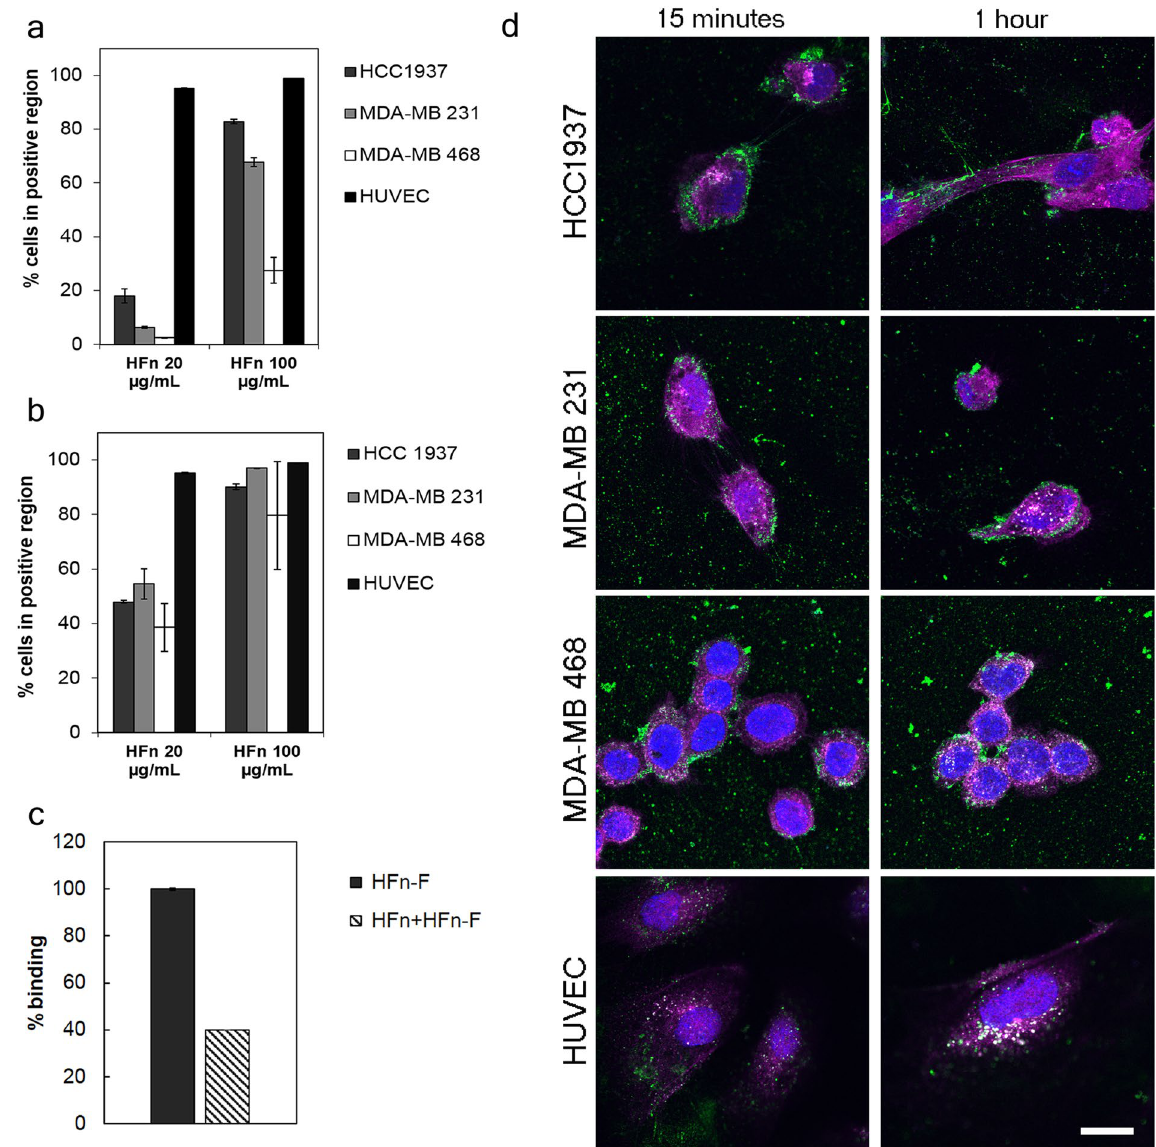
Figure 1. HFn recognition of Triple-Negative Breast Cancer cells. ( a ) MDA-MB 231, MDA-MB 468, HCC1937 (for TNBC) and HUVEC cells were incubated 2 h at 4 °C in PBS buffer and 0.3% BSA with different amounts of FITC-labelled HFn nanoparticles (20 and 100 µ g/mL). Then, cells were processed for flow cytometry, using untreated cells to set the positive region and the singlet gate. Reported values are the mean ± s.e. (n = 3). ( b ) MDA-MB 231, MDA-MB 468, HCC1937 (for TNBC) and HUVEC cells seeded in a multiwell plate were incubated 1 h at 37 °C in complete cell culture medium with different amounts of FITC-labeled HFn nanoparticles (20 and 100 µ g/mL). Then, cells were detached, washed and processed for flow cytometry, using untreated cells to set the positive region and the singlet gate. Reported values are the mean ± s.e. (n = 3). ( c ) Competition assay. HCC1937 cells were incubated 1 h at 37 °C with 100 µ g/mL of FITC-labelled HFn with or without an excess of unlabeled HFn ( i.e ., 5 mg) as competitor. Cells were then detached and treated for flow cytometry. Untreated cells have been used to set the singlet gate and the positive region. Reported values are the mean ± s.e. (n = 3). ( d ) Colocalization of HFn and TfR1. Confocal images of MDA-MB 231, MDA-MB 468, HCC1937 (for TNBC) and HUVEC cells incubated 15 min or 1 h at 37 °C in complete cell culture medium with FITC-labeled HFn nanoparticles (green; 100 µ g/mL). Nuclei were stained with DAPI (blue). TfR1 was recognized with anti-TfR1 antibody (Abcam) and labeled with an anti-rabbit secondary antibody conjugated with Alexa Fluor 546 (magenta; Thermo Fischer Scientific). Scale bar: 10 µ